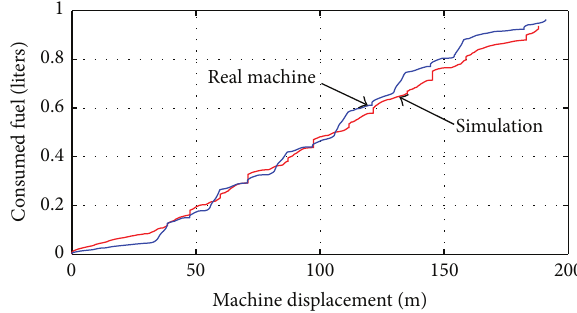
Figure 11: Validation machine velocity.